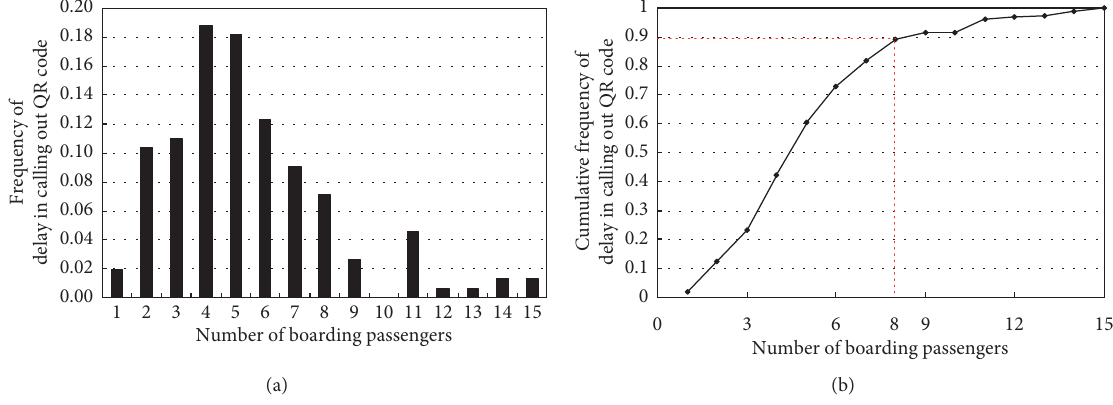
Figure 3: The distribution of the delay in calling out QR code with the boarding demand. (a) Frequency of delay vs. number of boarding passengers. (b) Cumulative frequency of delay vs. number of boarding